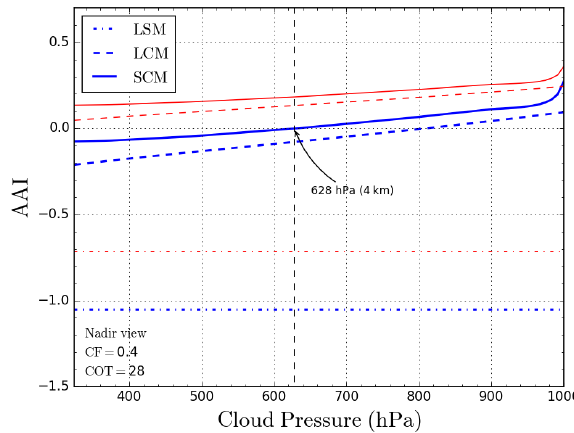
Figure 9. AAI sensitivity to errors in the input cloud top pressure for the LSM method (dash-dot), LCM method (dashed), and SCM method (solid) for HG clouds (blue) and Mie clouds (red). Refer- ence cloud pressure is 628hPa (4km). The scene has an effective cloud fraction of